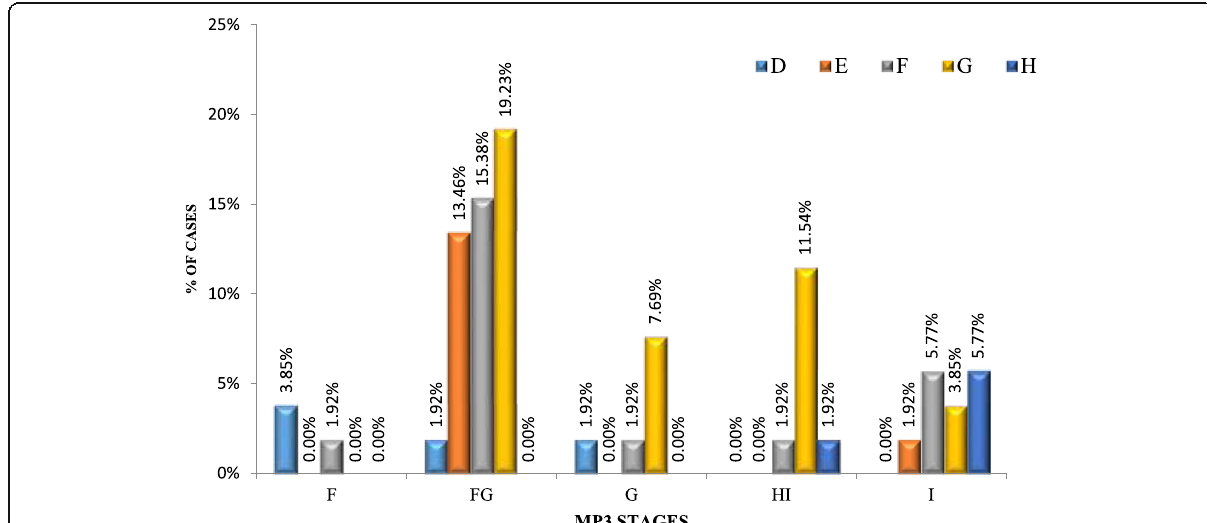
Fig. 3 Correlation between stages of modified MP3 and mandibular second molar in